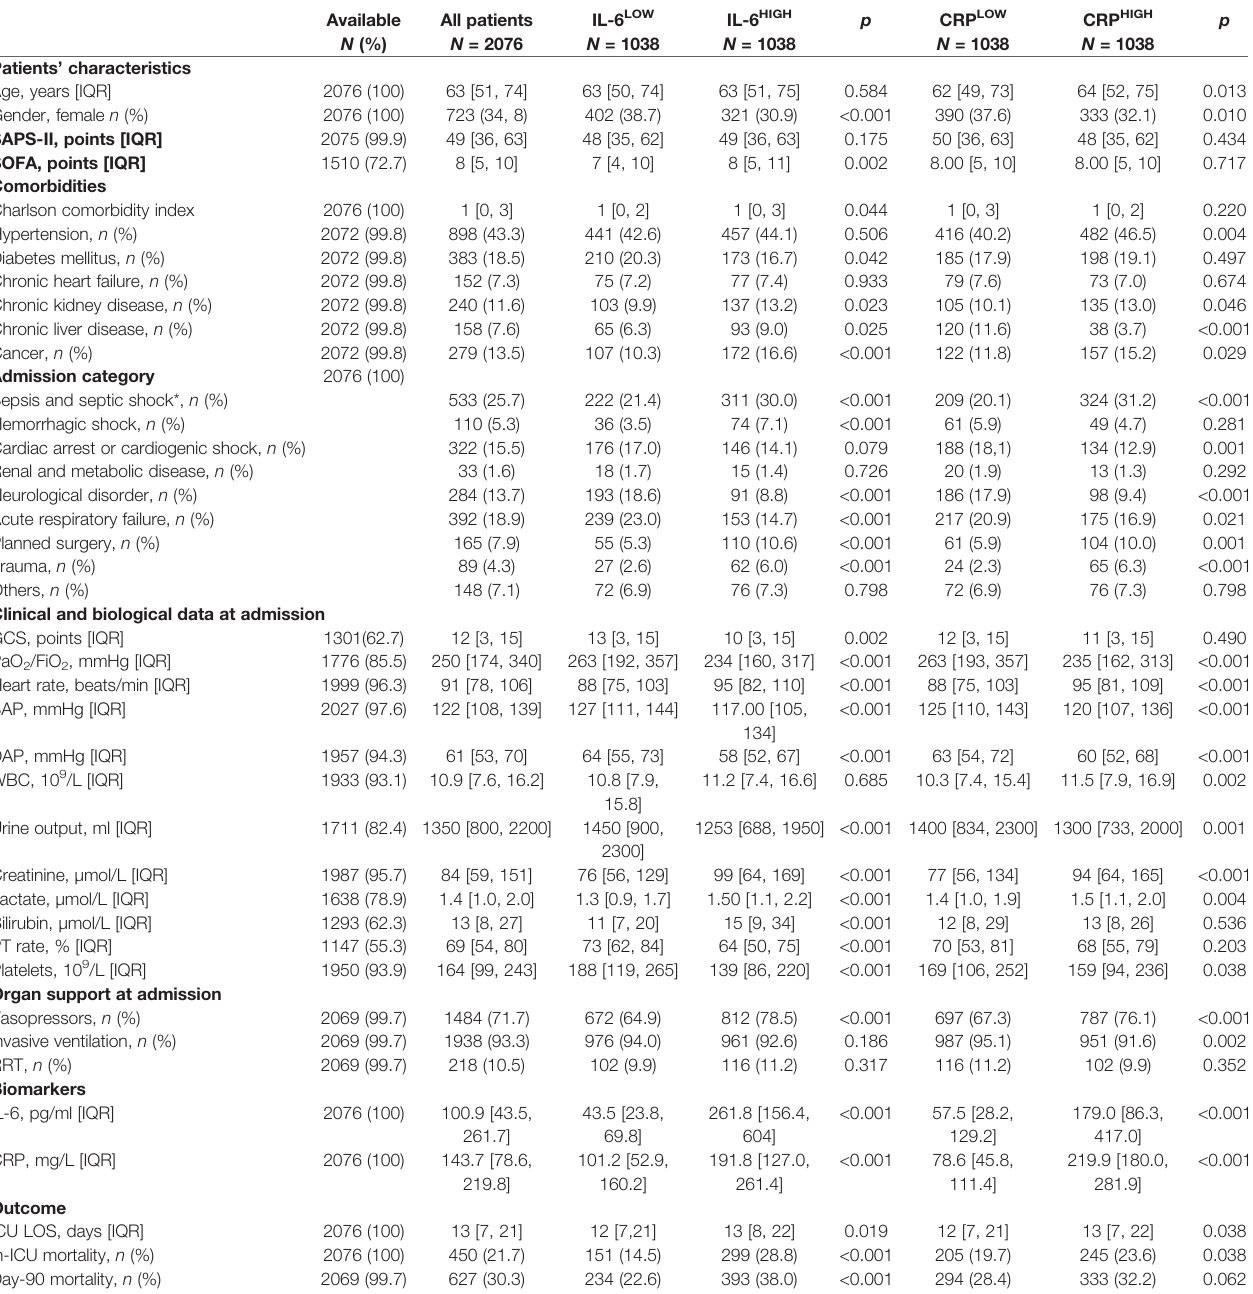
TABLE 1 | Patients ’ characteristics according to median IL-6 or CRP.